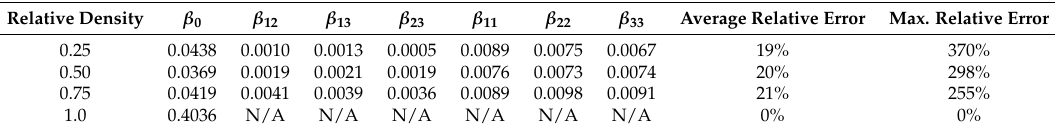
Table 2. Values of the coefficients β in the fitted meta-models. Average and maximum relative errors between FEA and our approach for 100 random simulations.